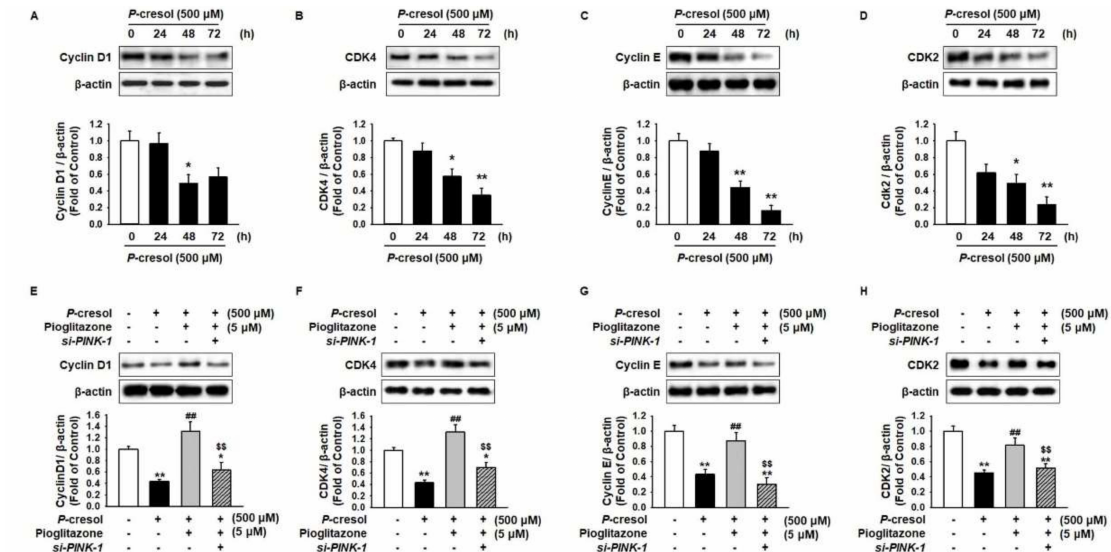
Figure 6. Pioglitazone-treated MSCs increased cell proliferation by regulation of PINK-1. ( A – D ) Western blot was used to analyze the expression of cell-cycle-associated proteins cyclin D1, cyclin-dependent kinase 4 (CDK4), cyclin E, and CDK2 in MSCs on exposure to PC (500 µ M) for 0, 24, 48, and 72 h. The expression levels were determined by densitometry relative to β -actin. Values represent the mean ± SEM * p < 0.05 and ** p < 0.01 vs. untreated MSCs. ( E – H ) After the 72 h PC (500 µ M) exposure, Western blot was used to analyze the expression of COX4 in MSCs after the 24 h treatment of si-PRNP -transfected MSCs with pioglitazone (5 µ M; 24 h). The expression levels were determined by densitometry relative to β -actin. Values represent the mean ± SEM. * p < 0.05 and ** p < 0.01 vs. untreated MSCs, ## p < 0.01 vs. MSCs exposed to PC, $$ p < 0.01 vs. MSCs treated with